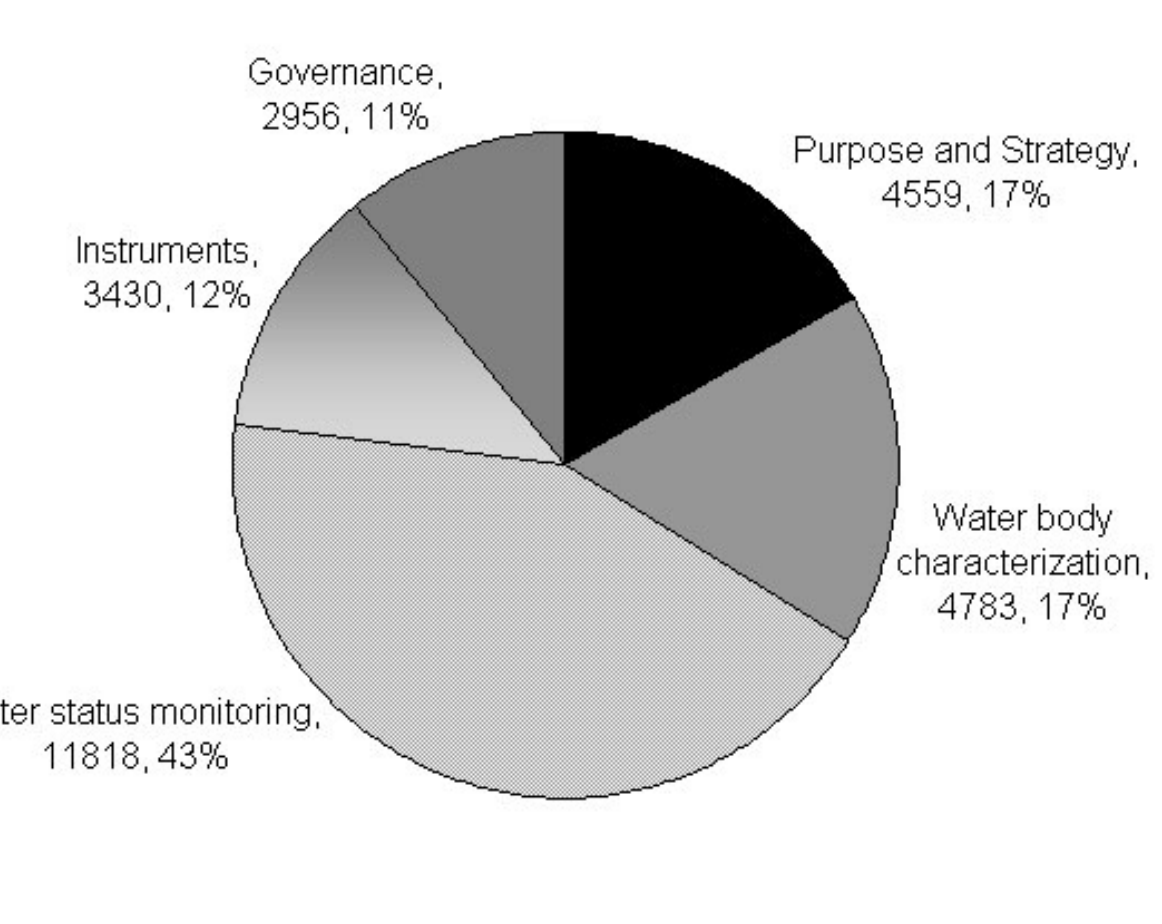
Fig. 2. Categorization of articles and annexes by number of words and